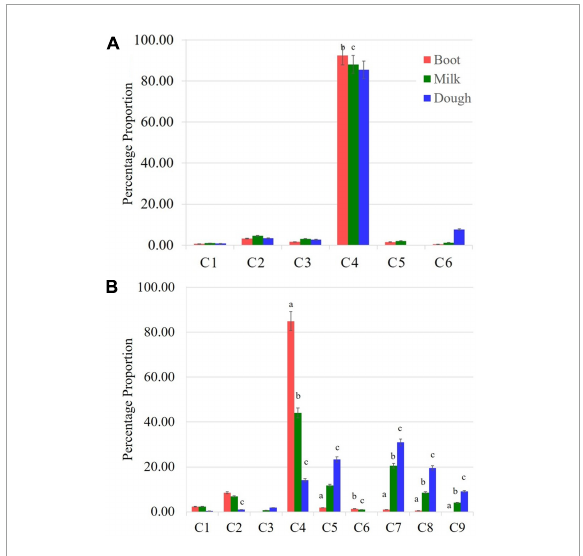
FIGURE2 Compositional variation for components of γ -oryzanol between non-seed (leaf blades (A) and seed tissue [Spikelets (B) ]. Leaf blades have only six components while nine components were found in spikelet tissue. C1: 24-methylenecycloartanyl- p - coumarate; C2: (cid:49) 7-stigmastenyl ferulate; C3: stigmasteryl ferulate; C4: cycloartenyl caffeate; C5: cycloartenyl ferulate; C6: campesteryl caffeate; C7: 24-methylenecycloartanyl ferulate; C8: campesteryl ferulate; C9: β -sitosteryl ferulate; significant difference between boot and milk stages (a) , milk and dough stages (b) , boot and dough stages (c)